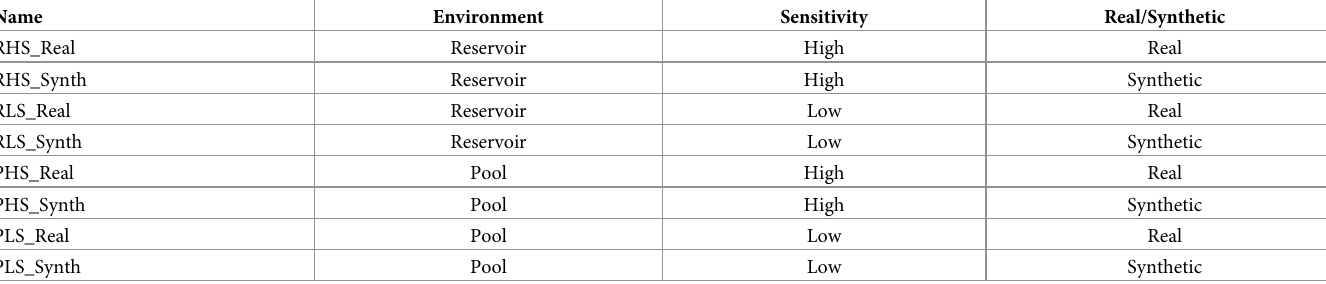
using the image translation NN.